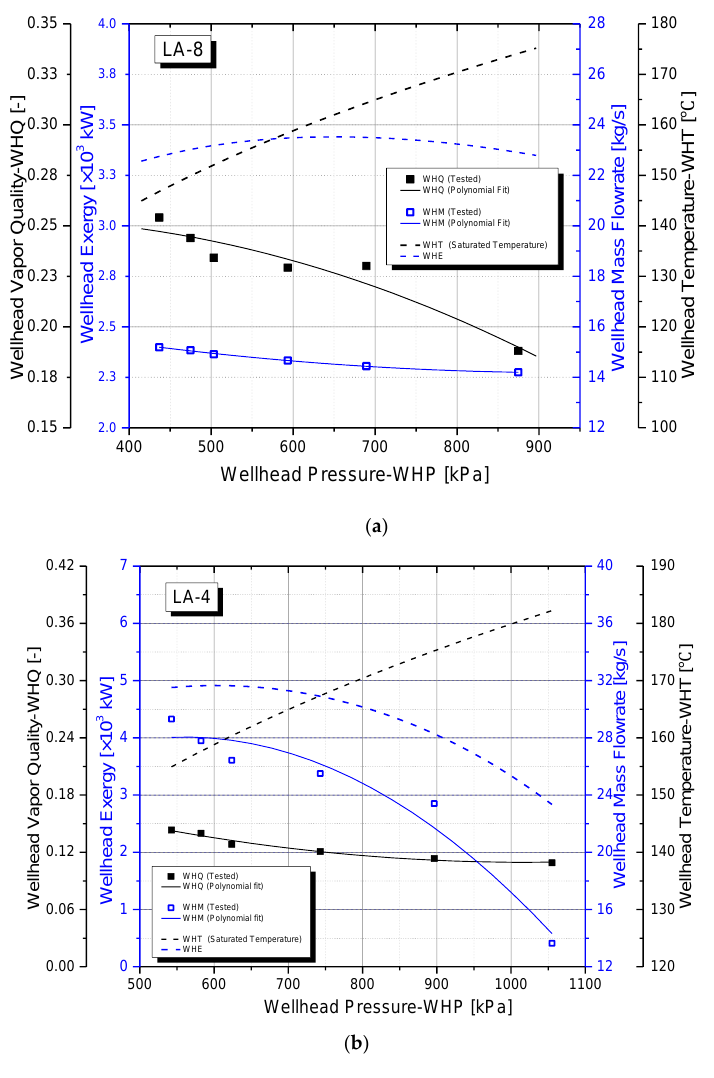
Figure 1. Wellhead information of geothermal wells ( a ) LA-8 and ( b ) LA-4.